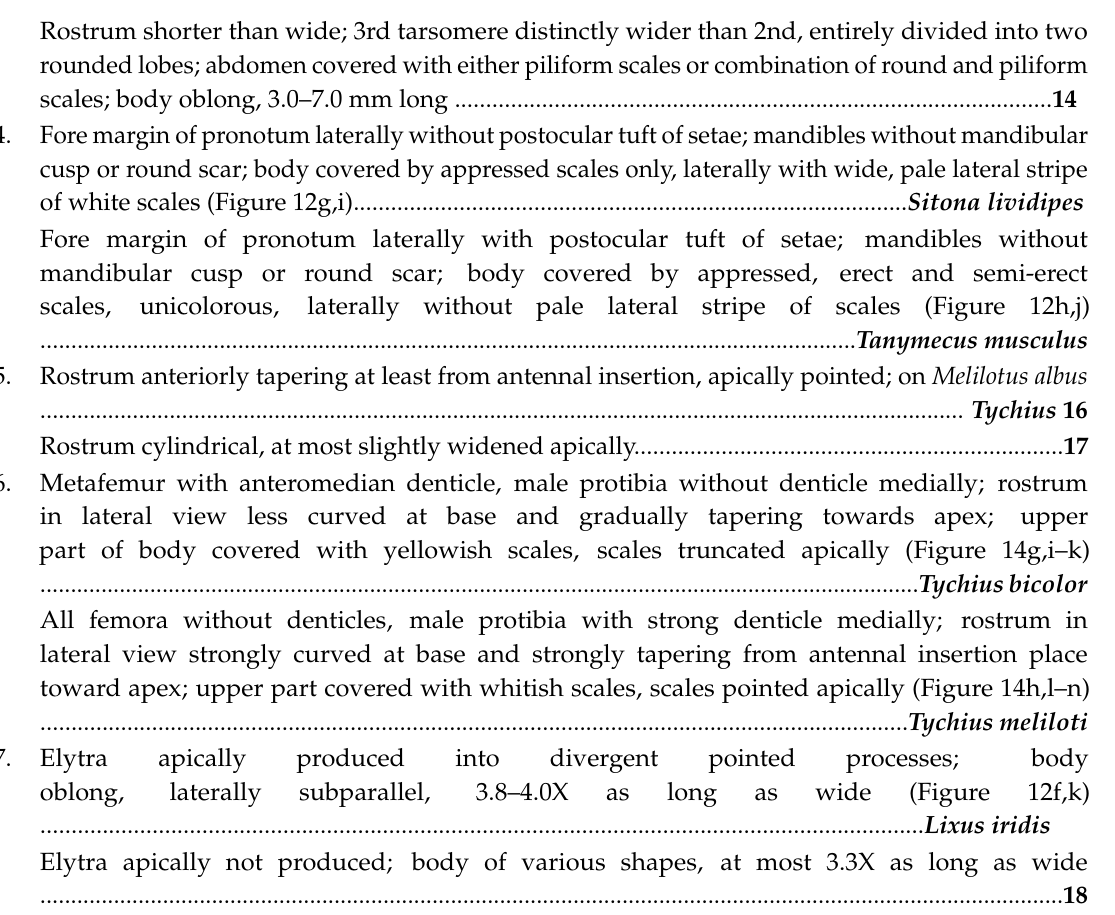
- Elytra apically not produced; body of various shapes, at most 3.3X as long as wide 18. Rostral channel absent; postocular lobes of pronotum absent, at most fore margin of pronotum laterally slightly rounded;